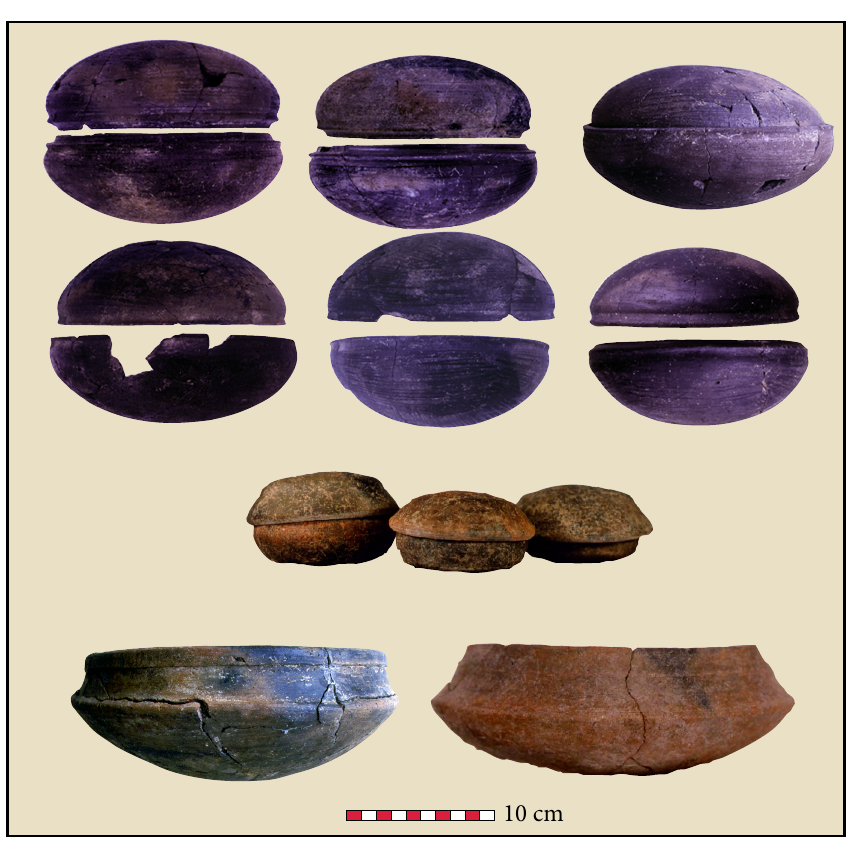
10 Fig. 16: Lidded ceramic vessels placed together with no clear association with burials are found in both the Upper Mun and the Lopburi areas. Upper two rows, Noen U-Loke, lower rows, Tha Kae.